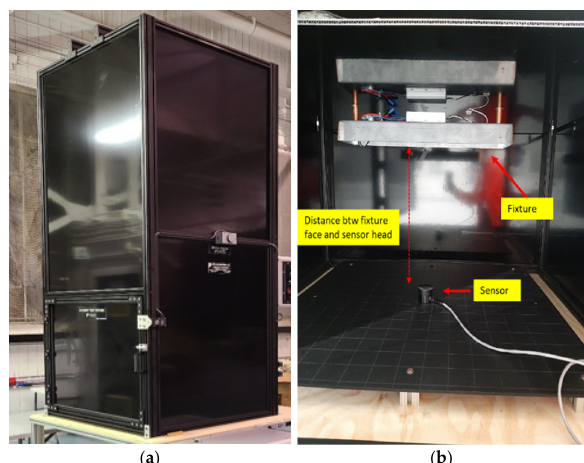
Figure 3. The test rig setup and characterization: ( a ) enclosed test rig; ( b ) test rig setup showing the fixture to install the light source and the sensor to measure the irradiance. After the irradiance meas ‐ urement, the sensor was replaced with viral sample in the actual experiment, and the distance was adjusted to 10 cm. The irradiances were measured at varying distances from 10 to 50 cm and the meas ‐ was adjusted to 10 ured values can be used for interpolating the irradiances at a desired distance.